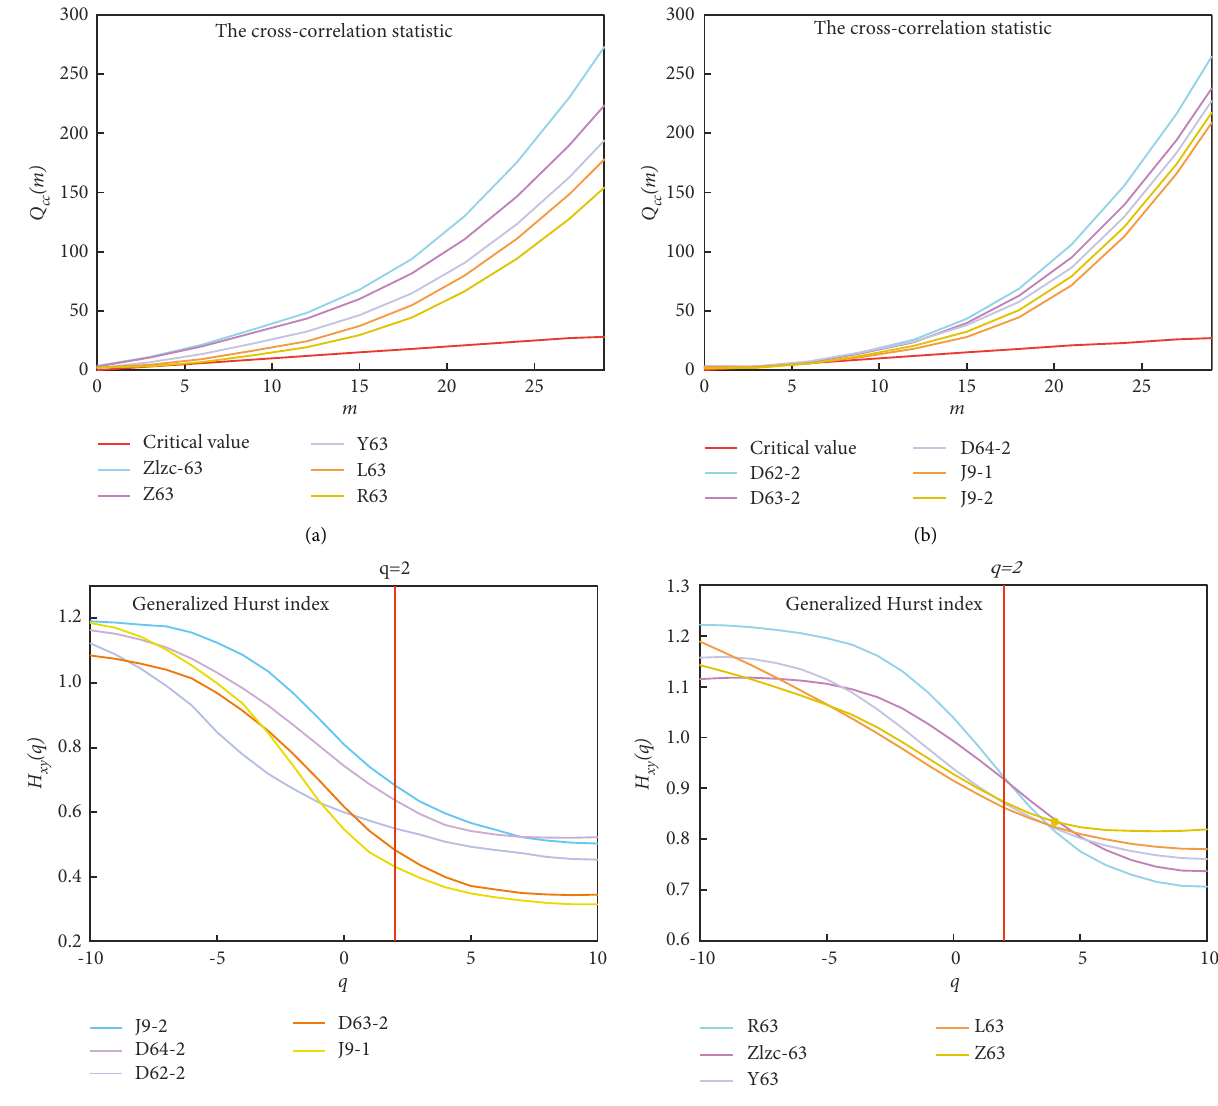
Figure 9: Cross-correlation statistic and generalized Hurst exponent between partial time series